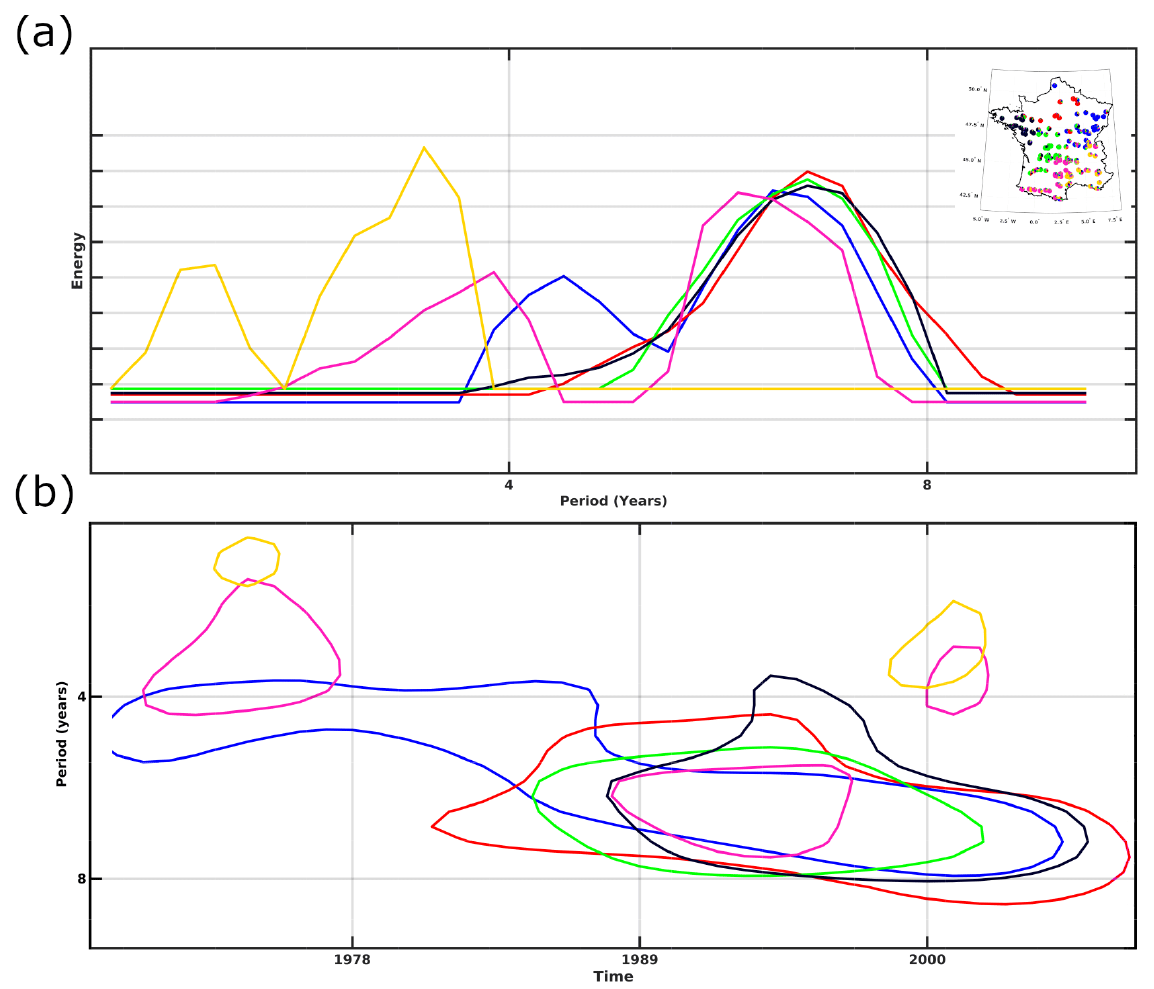
Figure 11. Interannual discharge time frequency variability in France. (a) Global wavelet spectra of homogeneous regions. (b) Wavelet spectra of homogeneous regions. For clarity, only timescales and time locations that are 95% statistically significant and with the largest variability are shown (colored